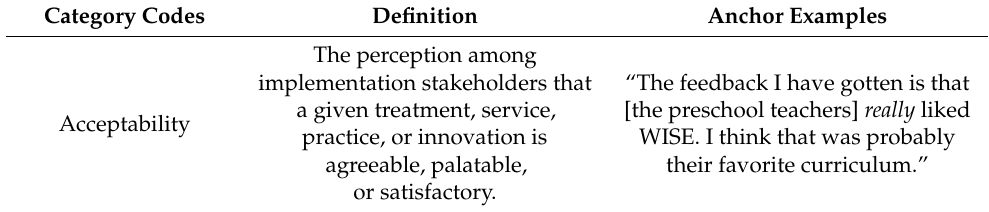
Table 2. Category definitions and anchor examples for the directed qualitative content